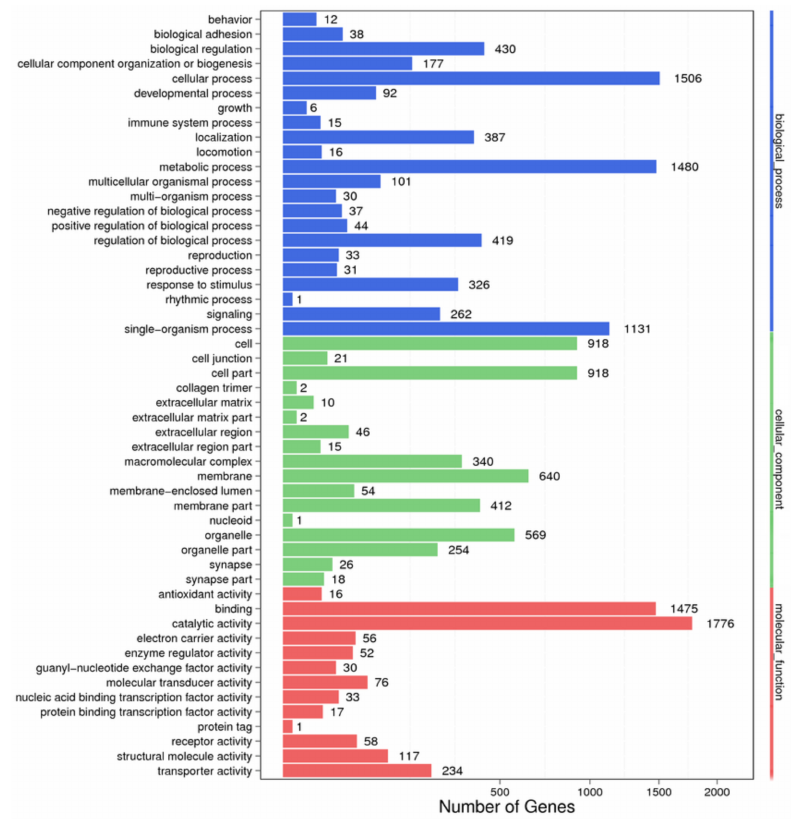
Figure 1. GO classifications of the assembled sequences from the Xenocatantops brachycerus